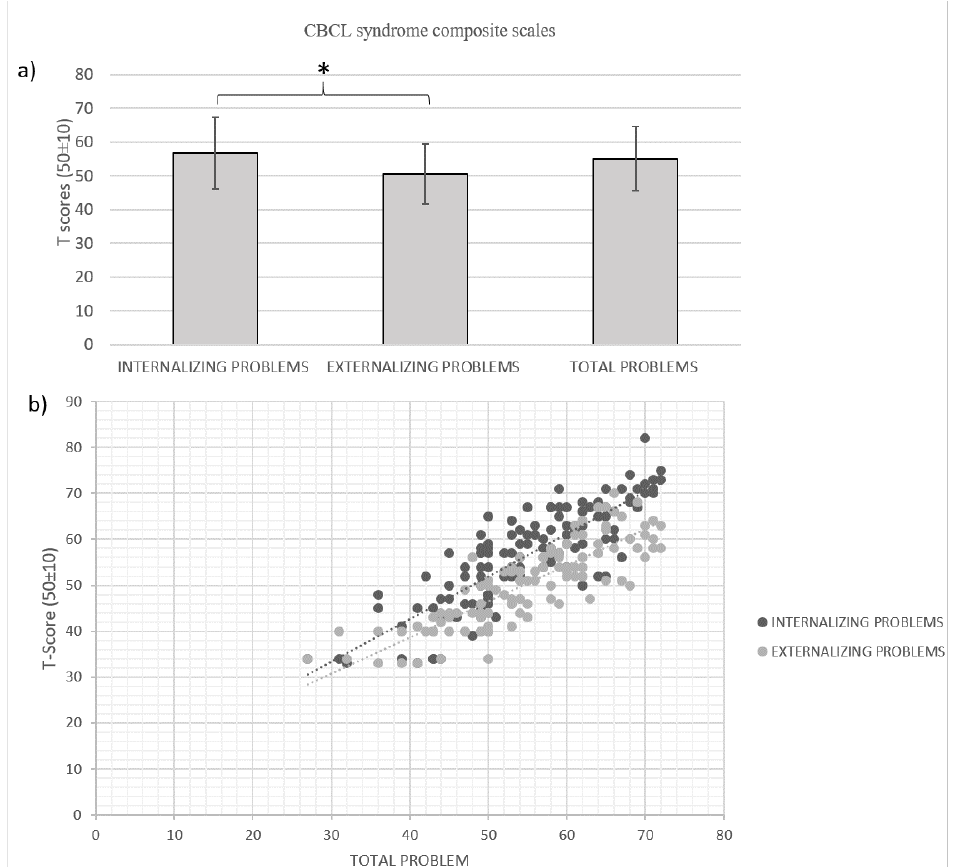
Figure 1. ( a ) Mean and Standard Deviation of T scores in each CBCL syndrome composite scale, * rep- resent the statistical significant differences (p < 0.05) between CBCL syndrome scales; ( b ) scatterplot distribution of Internalizing (black) and Externalizing (gray) Problems scales.